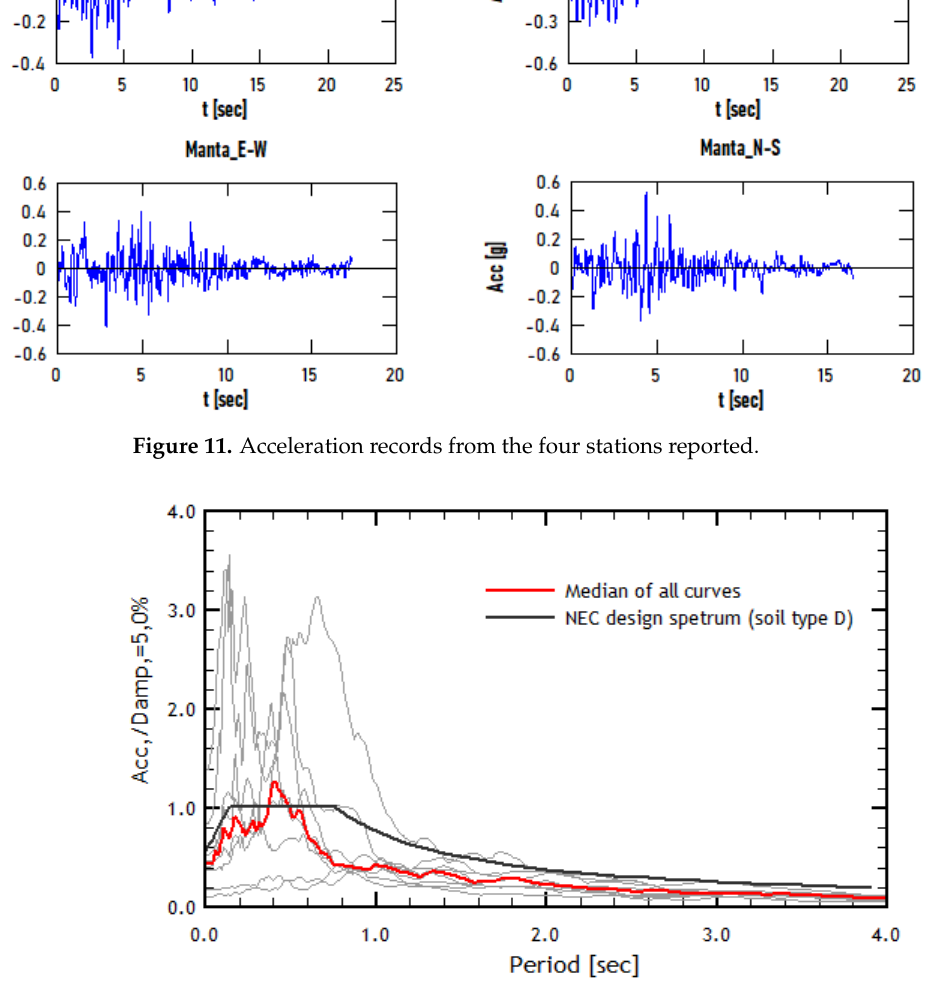
Figure 12. Response, mean, and elastic design spectra corresponding to the accelerograms used for the IDA. Table 6. Information from the records used for